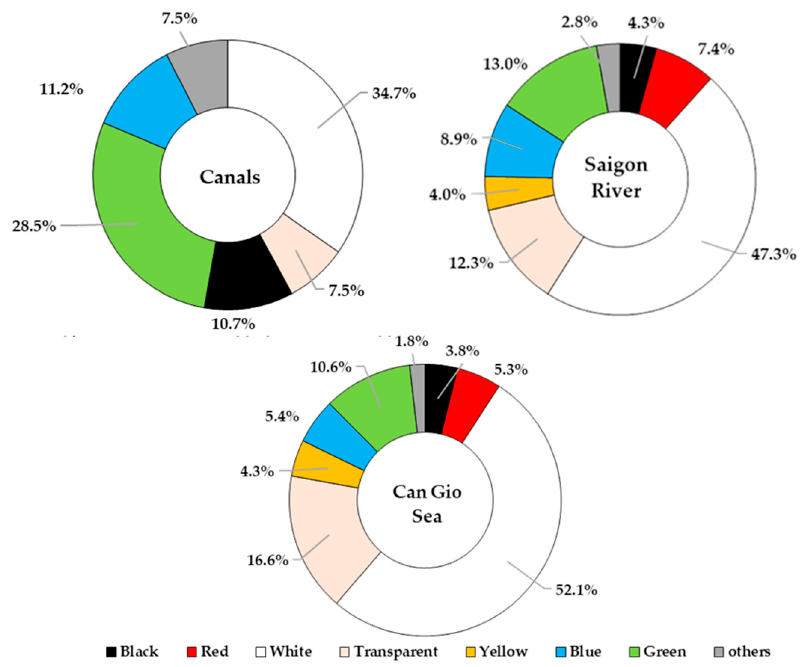
Figure 7. Color distribution of MPs in canal systems, Saigon River, and Can Gio Sea, in August 2020.